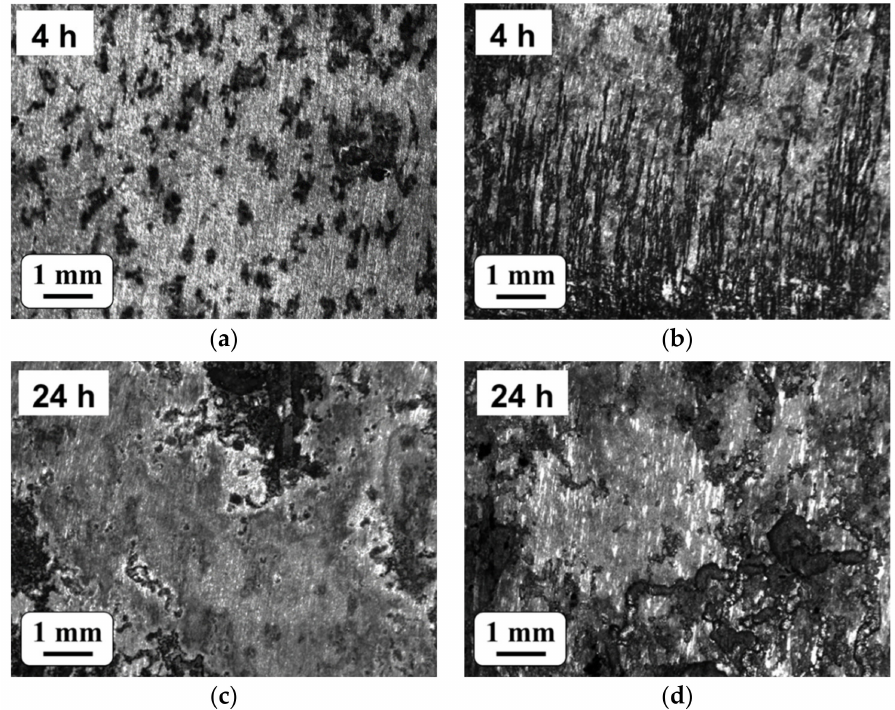
Figure 7. Macrographs of the corroded surface after 4 and 24 h immersion in 3.5 wt% NaCl solution saturated with Mg (OH) 2 at room temperature, and removal of corrosion products: ( a , c ) AM60; ( b , d ) AMX601